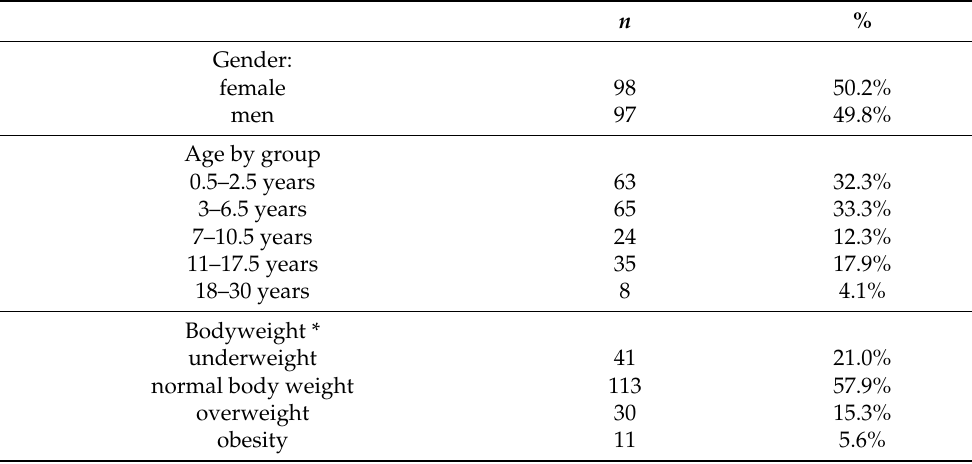
Table 2. Characteristics of the study group of participants with Down